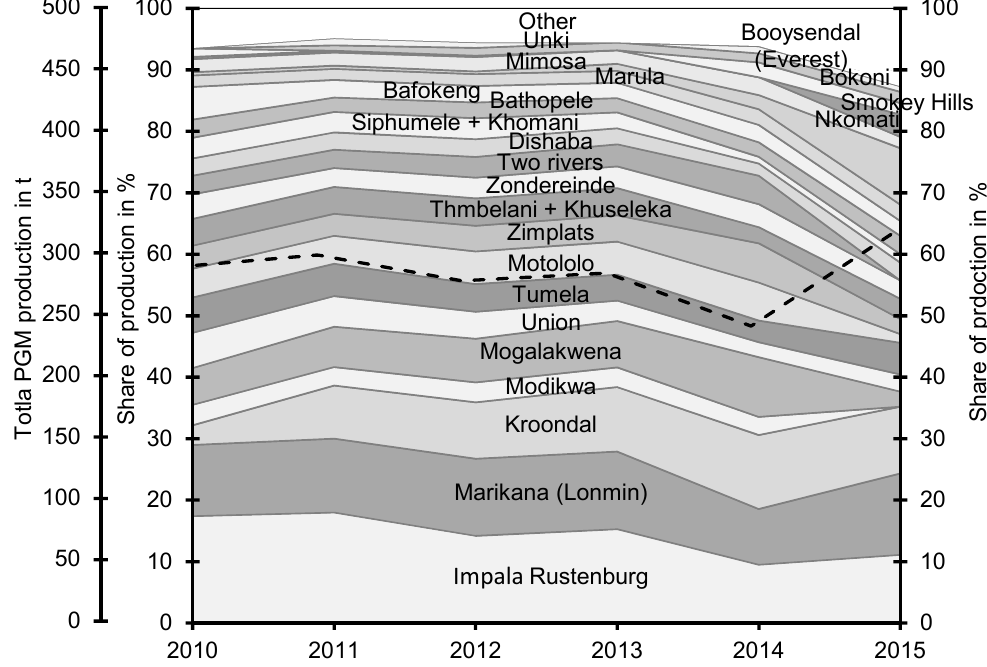
Figure 4. Production shares of different mines and total production (dashed line). Mines specified as “Others”comprise Blue Ridge, Twickenham, Tharisa, Chromite tailings retreatment facility, Eland, Crocodile River, Platinum Mile retreatment facility, Marikana (Aquarius), Pilanesberg, Western Limb Tailings Retreatment, Pandora, Limpopo mines.